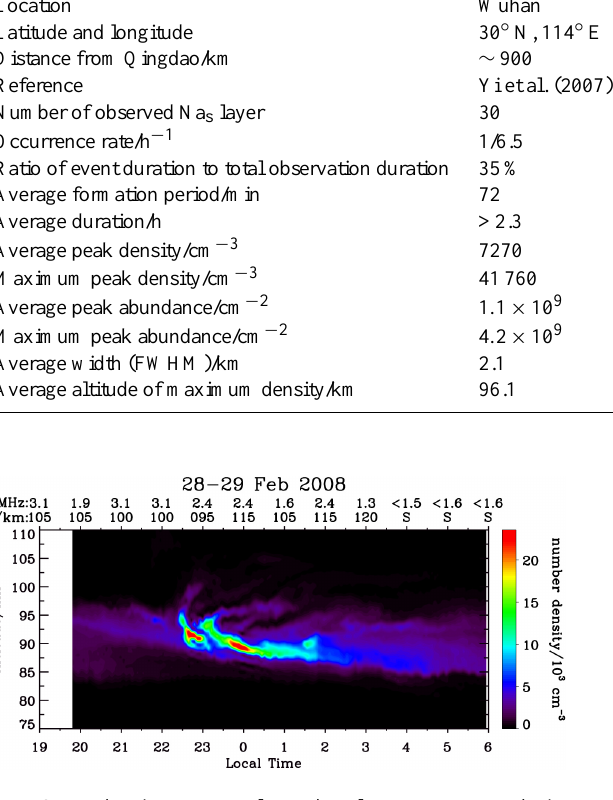
Figure 4. Na density contour plot and E s layer parameters during the night of 16–17 May 2011. Note the temporally correlated spo- radic Na and E layers occurring before